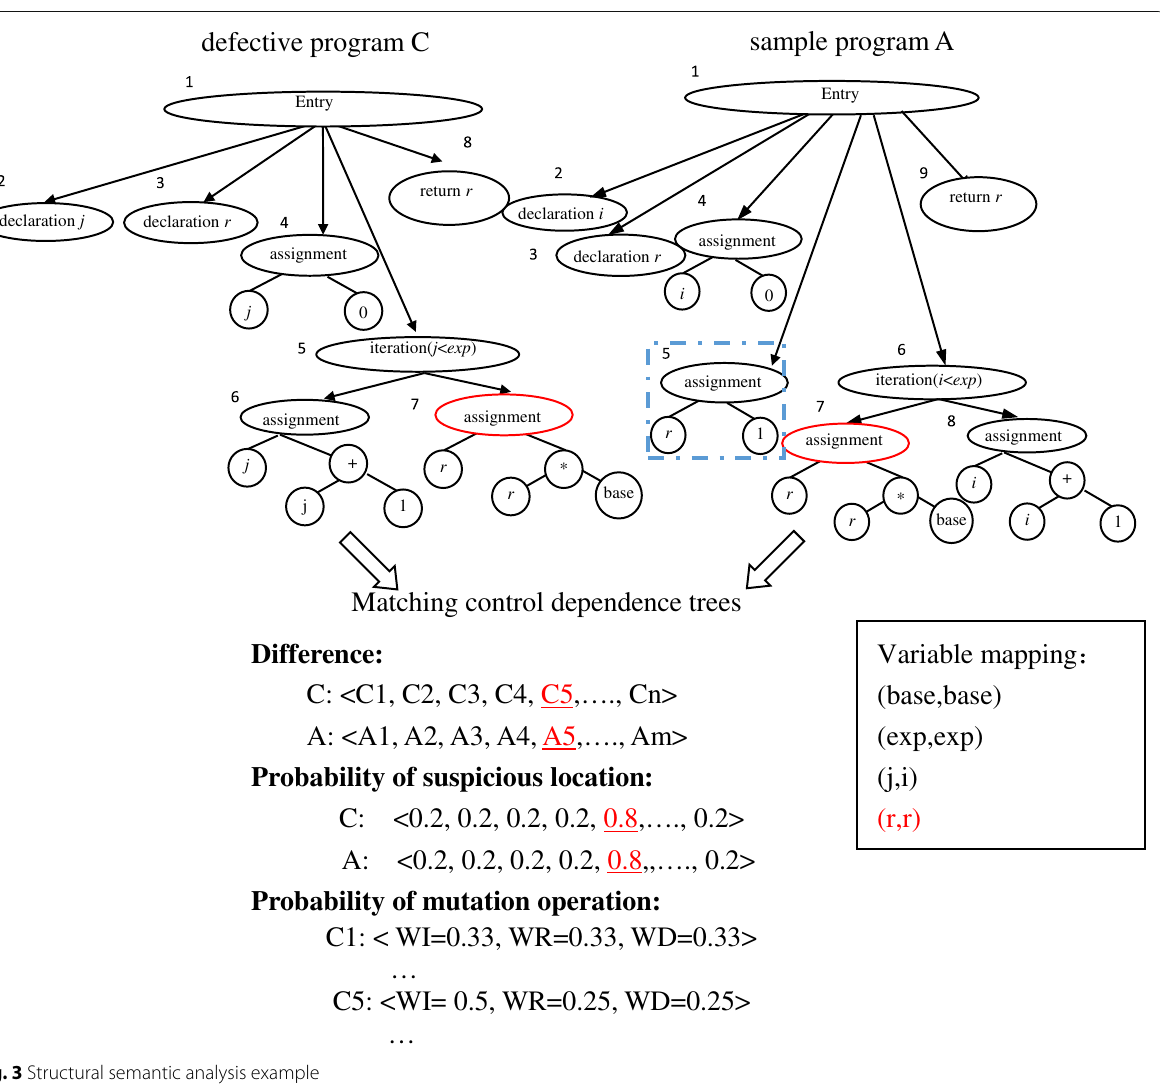
Fig. 3 Structural semantic analysis example